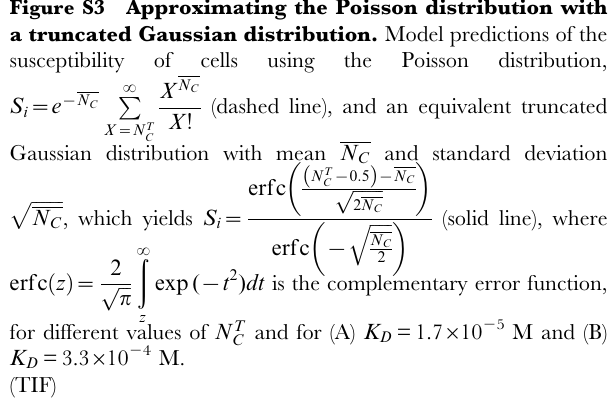
the initial viral load, V 0 =40 ffu ? ml 2 1 (thick solid line), 400 ffu ? ml 2 1 (thin solid line), and 4000 ffu ? ml 2 1 (dashed line), (IV) the infection rate constant, b = 1.2 6 10 2 3 ml ? (ffu ? d) 2 1 (thick solid line), 1.2 6 10 2 4 ml ? (ffu ? d) 2 1 (thin solid line), and 1.2 6 10 2 5 ml ? (ffu ? d) 2 1 (dashed line), (V) the viral production rate, p =0.278 ffu ? (ml ? d) 2 1 (thick solid line), 2.78 ffu ? (ml ? d) 2 1 (thin solid line), and 27.8 ffu ? (ml ? d) 2 1 (dashed line), and (VI) the number of cell sub-populations, K = 40 (thick solid line), 80 (thin solid line), and 120 (dashed line). (The three curves in (VI) are indistinguishable.) Figure S2 Initial distribution of the CD81 expression level on target cells. Distribution of the CD81 expression level on (A) Huh-7.5 cells and (B) Huh7-Lunet cells (diamonds) and Lunet/CD81 cells (circles) obtained by digitizing data from Koutsoudakis et al. (2007) J Virol 81:588–598 and converting fluorescence intensities to CD81 surface densities (Methods). Figure S3 Approximating the Poisson distribution with a truncated Gaussian distribution. Model predictions of the susceptibility of cells using the Poisson distribution, (dashed line), and an equivalent truncated X ! Gaussian distribution with mean N C and standard deviation ffiffiffiffiffiffiffi p N C , which yields S i ~